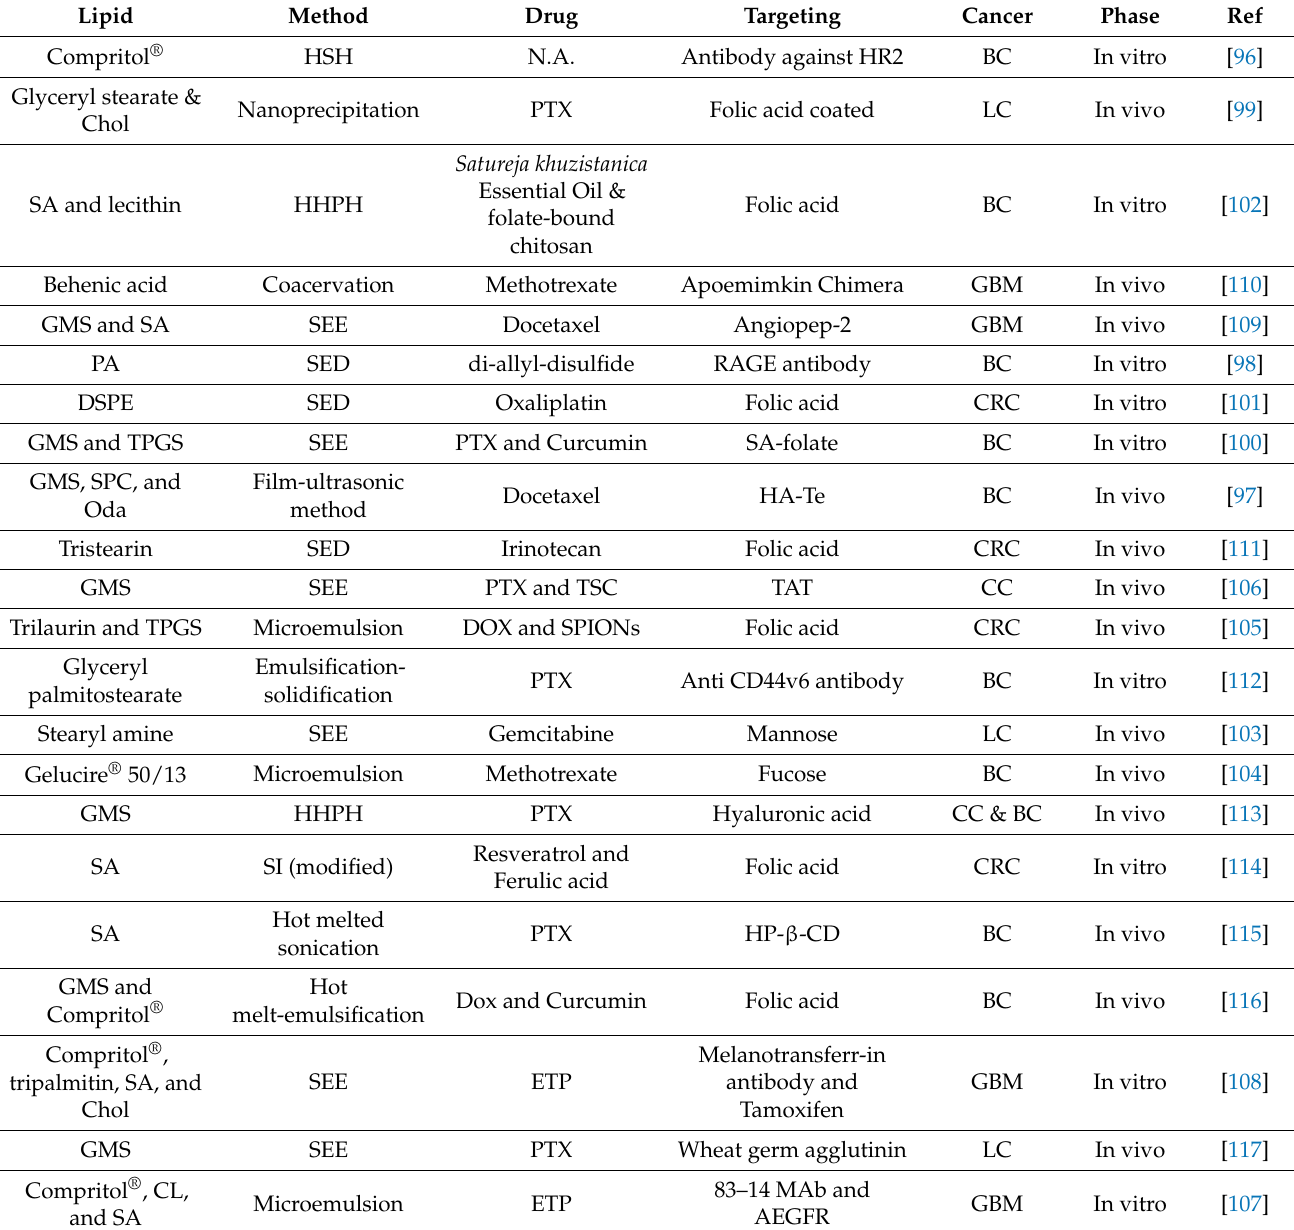
Table 4. Summary of targeted SLNs for different cancer types in different stages of